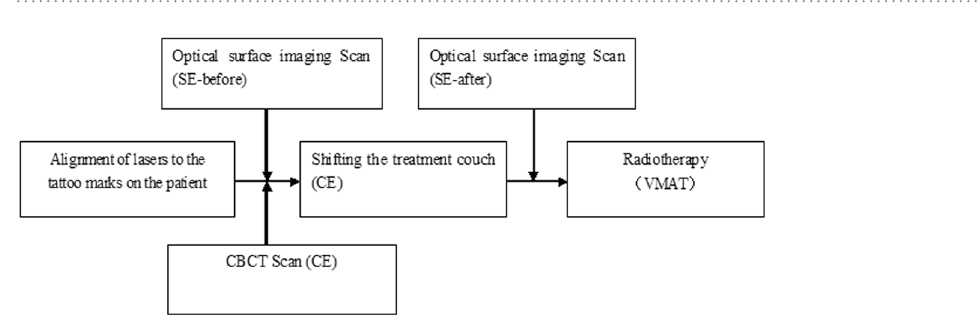
Figure 3. Flow chart of research